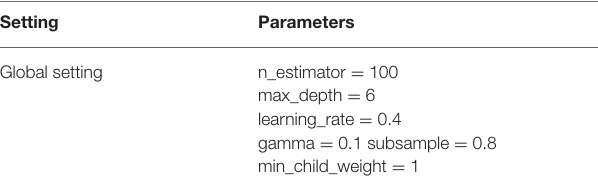
TABLE 1 | The labeling rules of the classification behavior description. TABLE 2 | The setting of hyperparameters of XGB